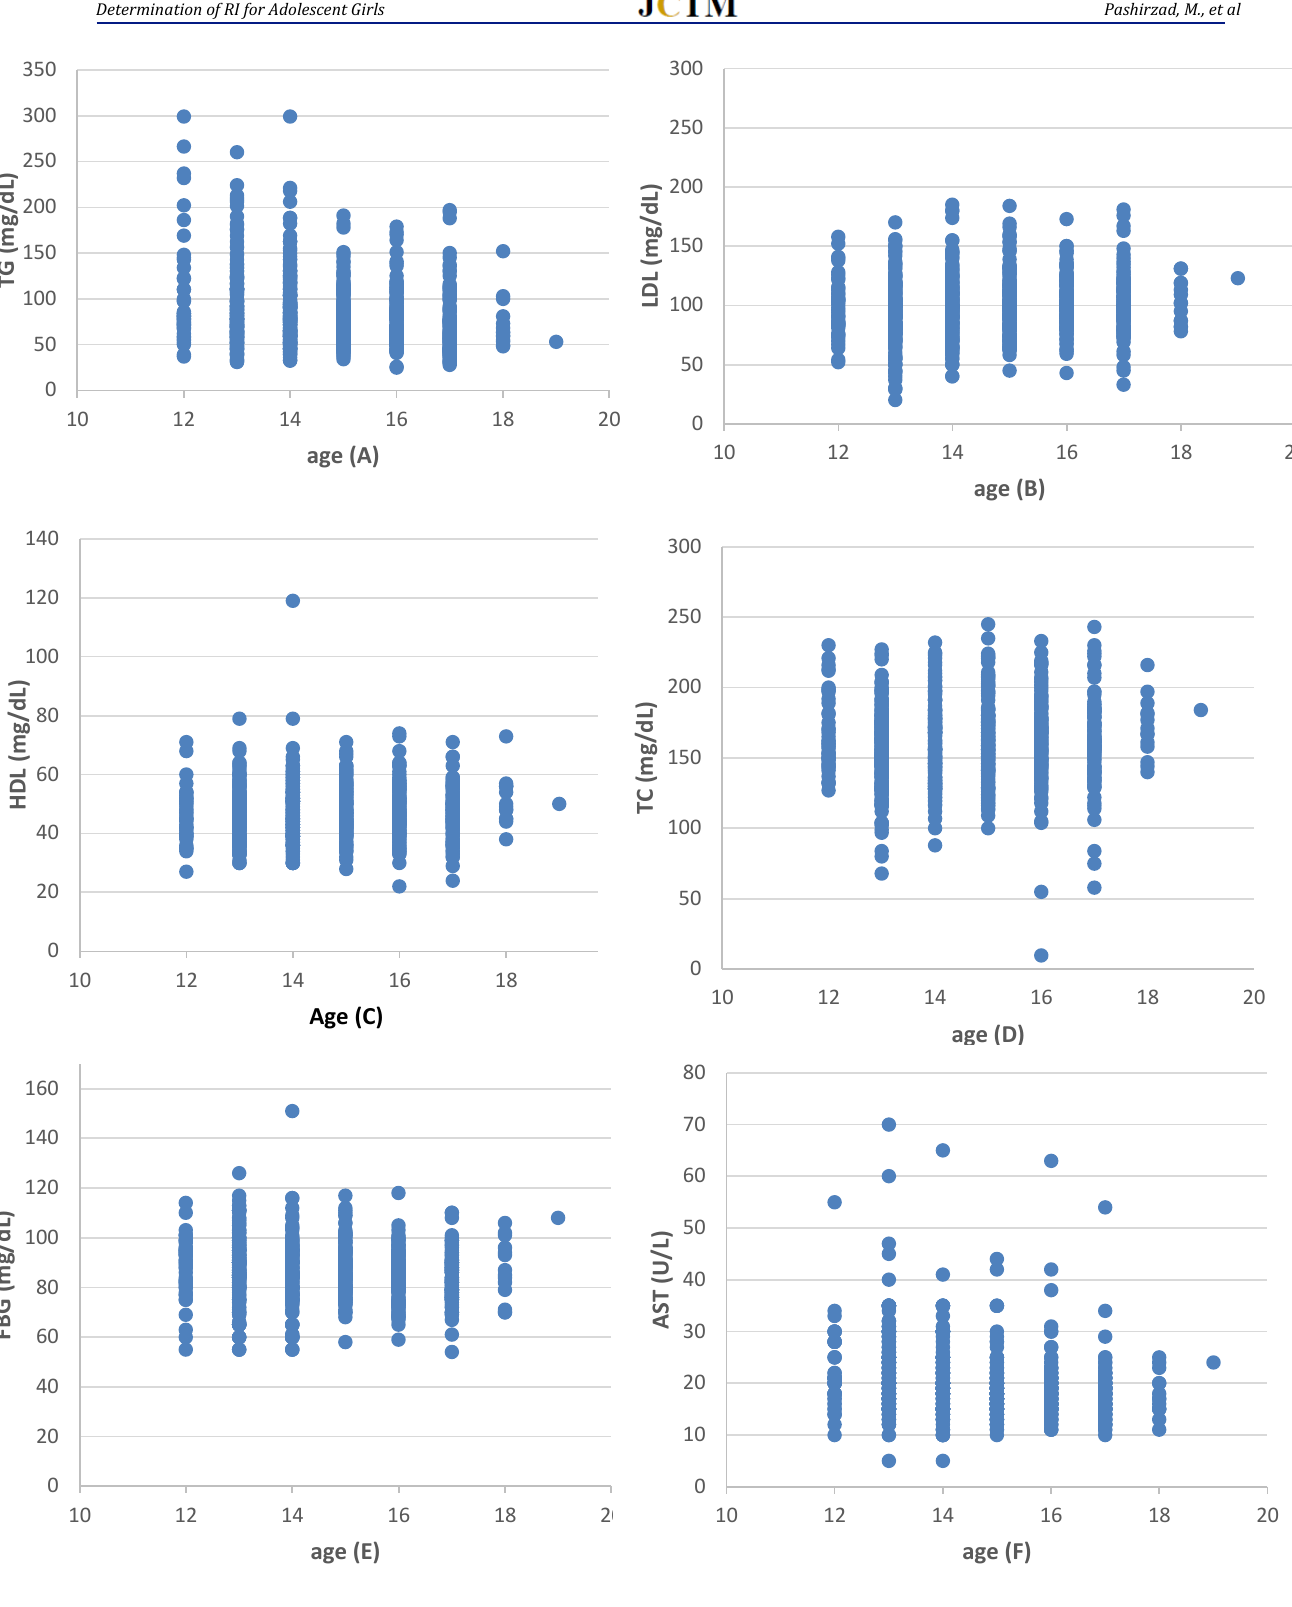
Figure 1. Scatterplot distribution for serum total cholesterol (mg/dL), triglyceride (mg/dL), low-density lipoprotein (mg/dL), high-density lipoprotein (mg/dL), fasting blood sugar (mg/dL), AST (U/L), ALT (U/L), ALP (U/L), Hs-CRP (mg/L), calcium (mg/dL), phosphate (mg/dL), vitamin D (ng/dL), creatinine (mg/dL), blood urine nitrogen (mg/dL) (A-N). Blue horizontal lines depict adolescent girls-specific lower and upper reference